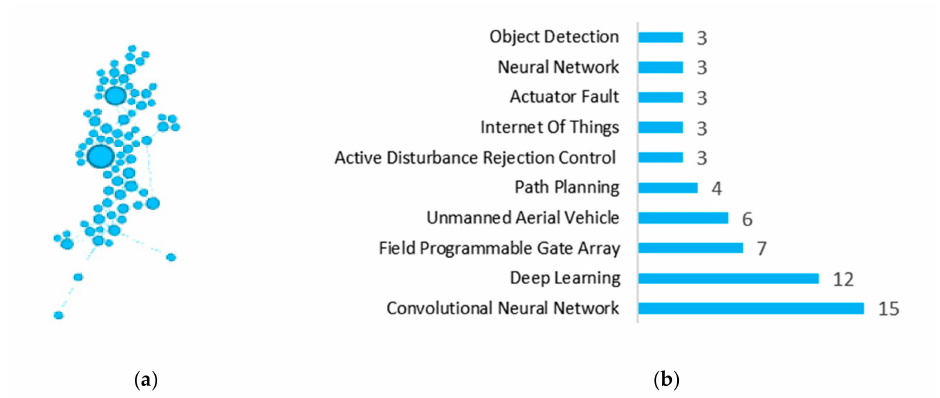
Figure 14. Representation of the Machine Learning Systems Community: ( a ) Isolated distribution of publications. ( b ) Keywords of the